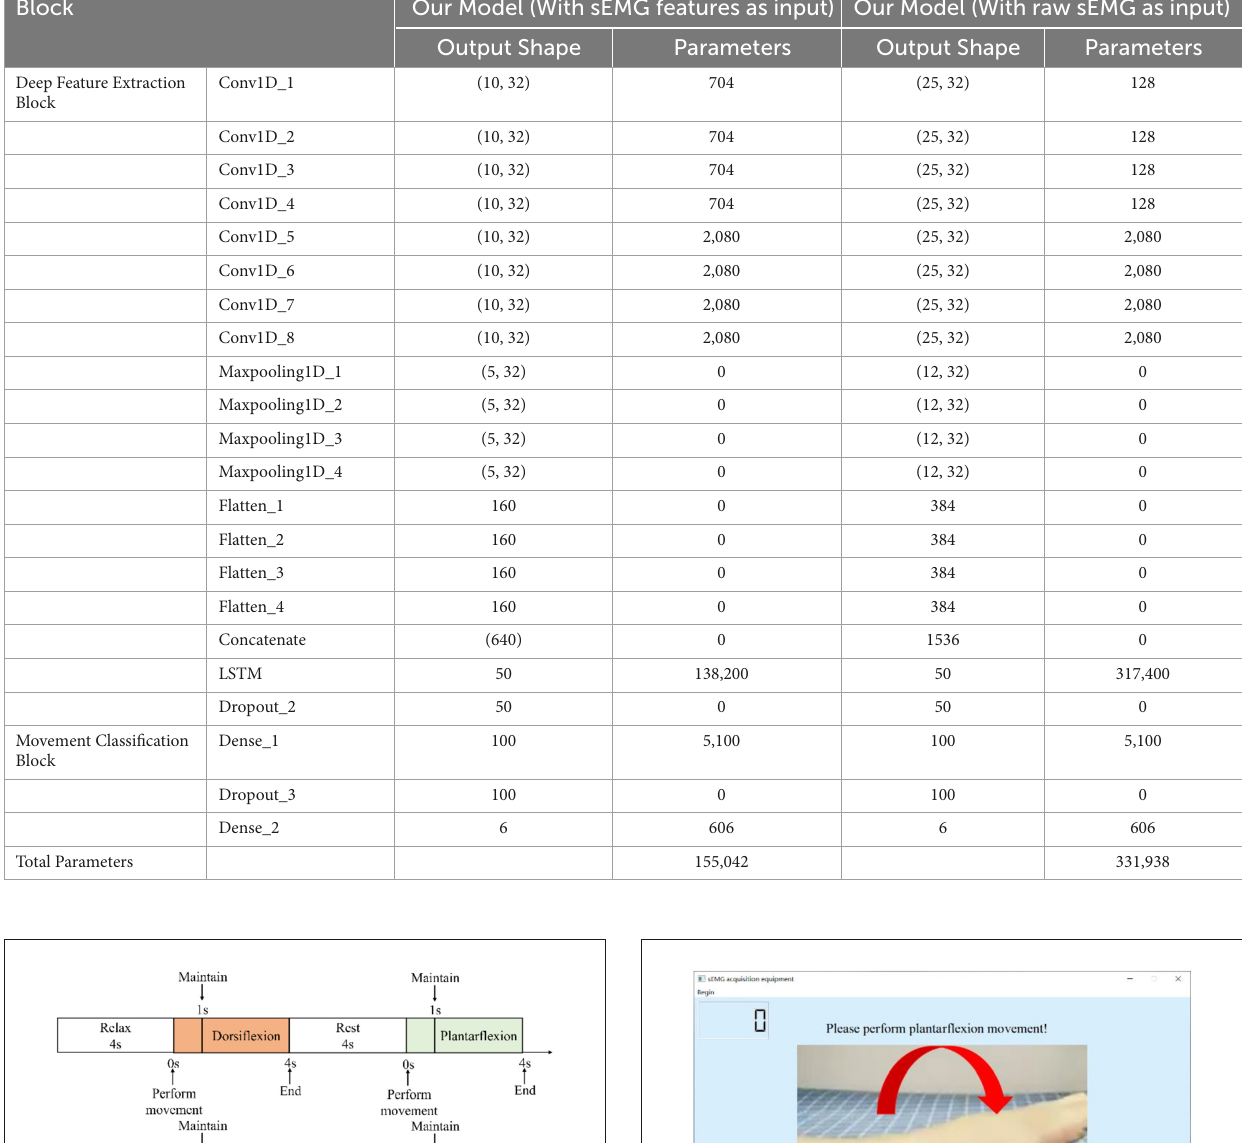
TABLE 2 Our model parameters details.